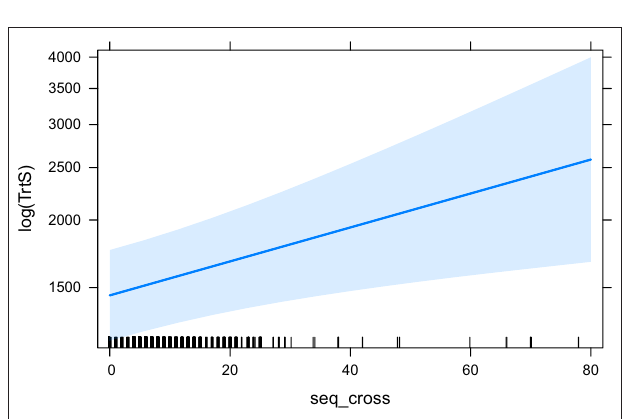
FIGURE 10 | The effect of seq_cross on the logarithm of TrtS.